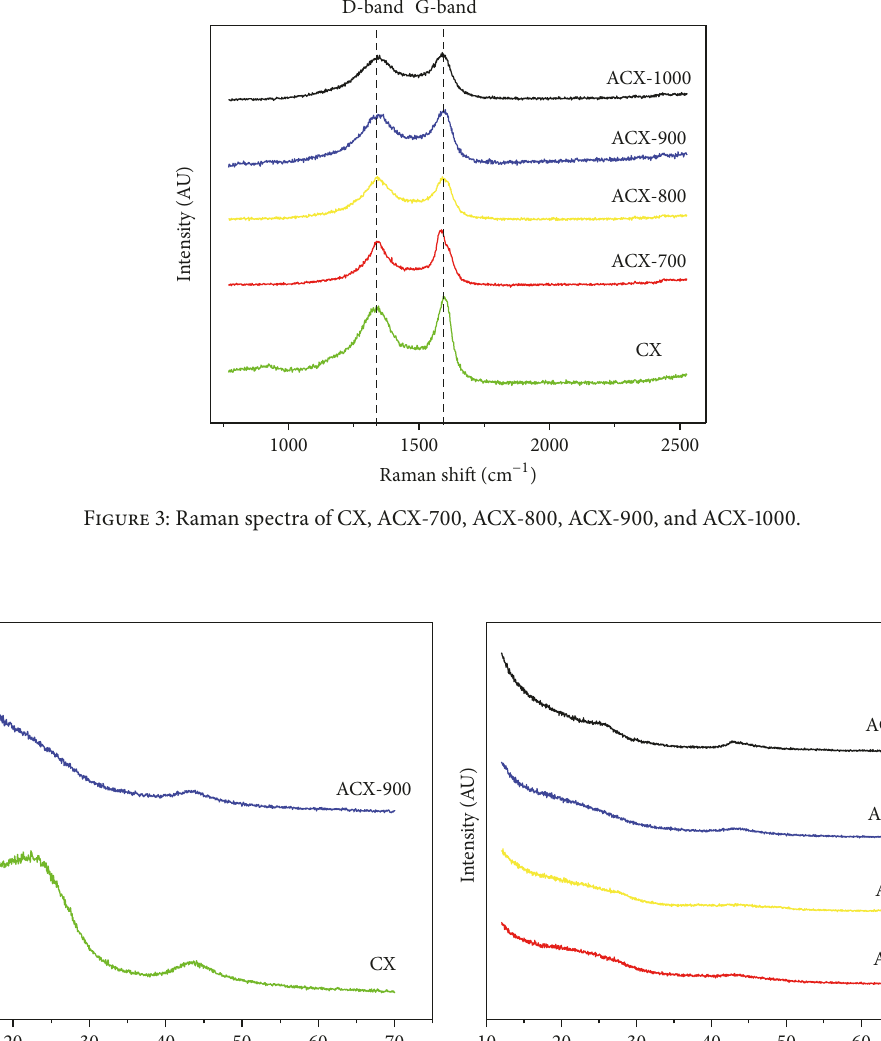
Table2:PeakpositionandintensityratiooftheD-bandwithrespect to the G-band ( 𝑅 = 𝐼